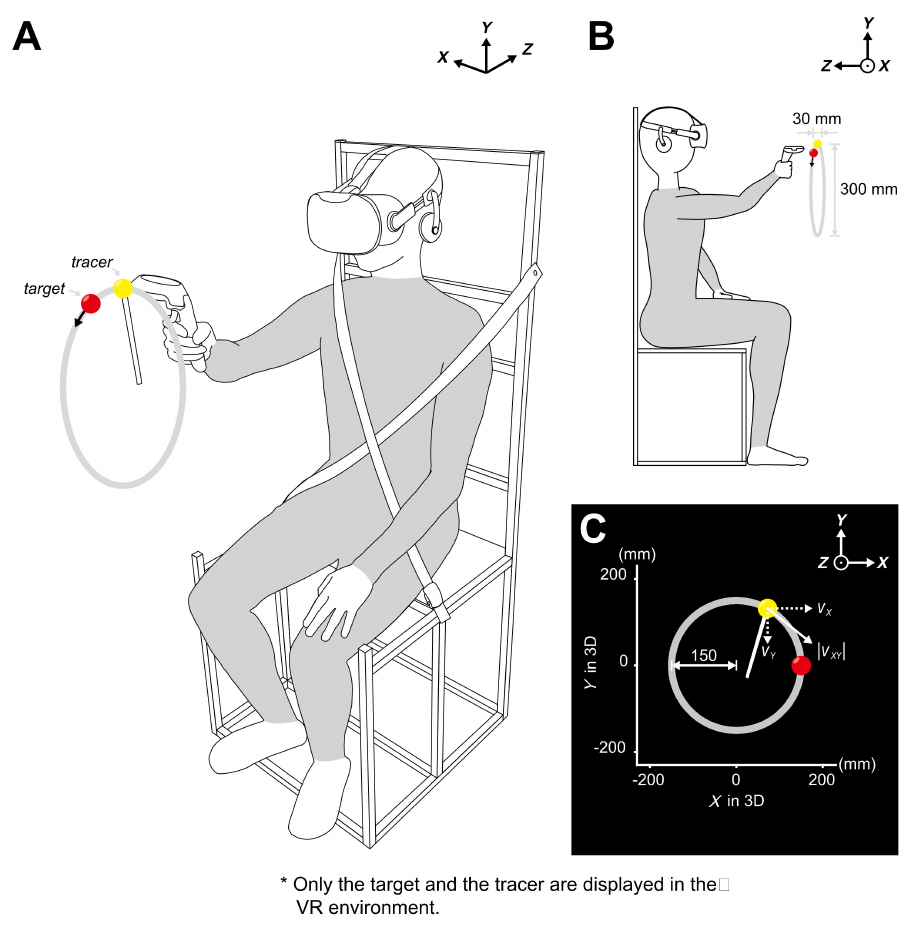
Figure 1. Experimental procedure for the circular tracking experiment. ( A ) Subject sitting on an experimental chair and holding a hand-held controller to conduct the target tracking movement with the virtual reality (VR) head-mounted display on. To restrict upper-body interference, belts are crossed on the subject’s chest. The target (red ball) is only visible in the 3D VR environment, while the tracer (yellow ball) indicates the current 3D location of the controller. The orbit of the target is invisible to the subject. ( B ) The sizes and trajectory of the balls. The target must move along a virtual trajectory with a diameter of 300 mm. They are instructed to follow the target with the tracer. ( C ) The target moves within the frontal plane and the velocity of the tracer is